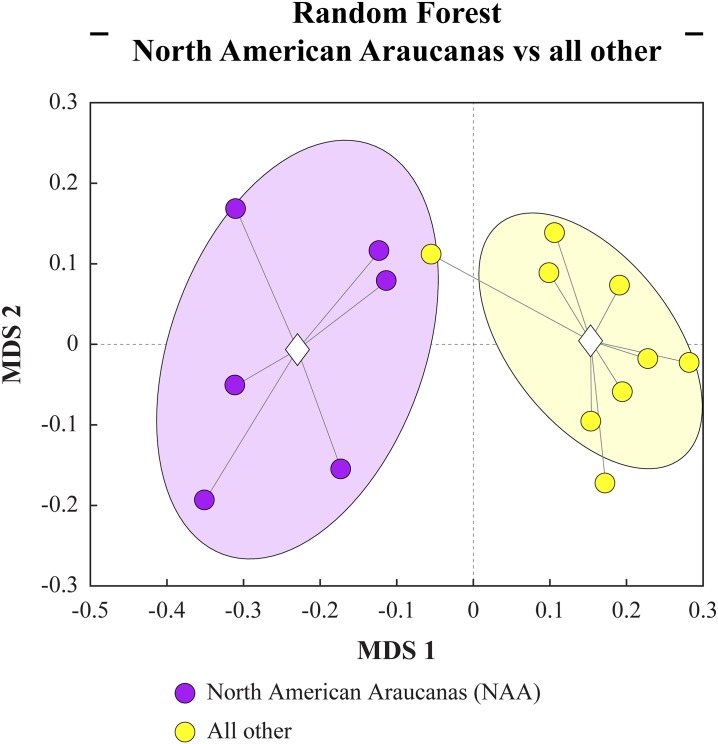
Visualization of multidimensional scaling plot.Discriminant model from random forest analysis on North American Araucanas (NAAs) compared to all other groups. The ellipses represent three standard errors around the centroid for each group. Violet dots represent NAA. Yellow dots represent the combined group of birds from Korean Domestics, White Leghorns and Korean Araucana.